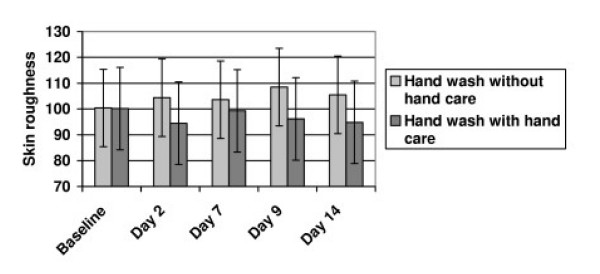
Mean skin roughness (and SD) measured on the forearms over two weeks; hand and forearms were washed daily 4 times for 2 min with a neutral soap, without hand care after the washes (group 1) and with a single application of a hand cream after each wash (group 2).